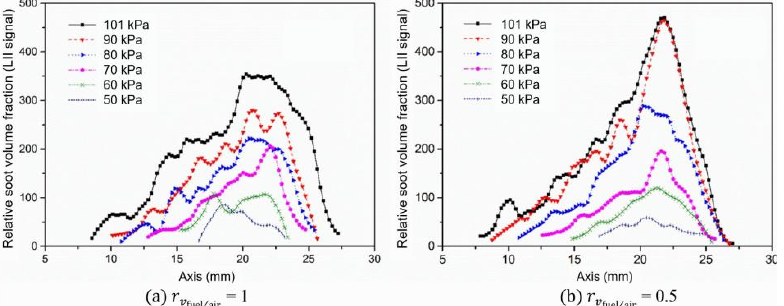
Figure 7. Relative soot volume fraction along the axis of the flame with r v ( fuel/air ) = 1 ( a ) and 0.5 ( b ). The peak relative soot volume fraction ( f ∗ ) versus pressure is plotted in Figure v , max